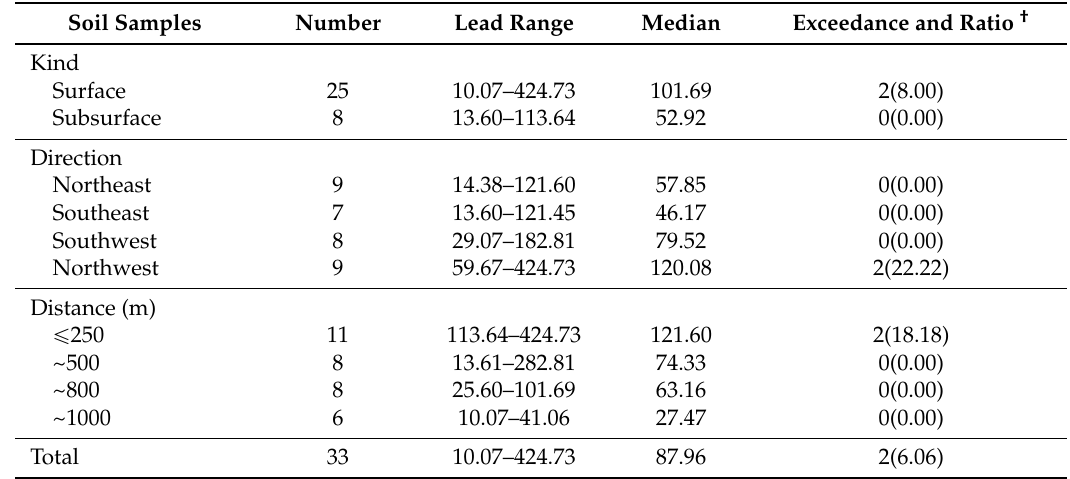
Table 7. The results of soil samples